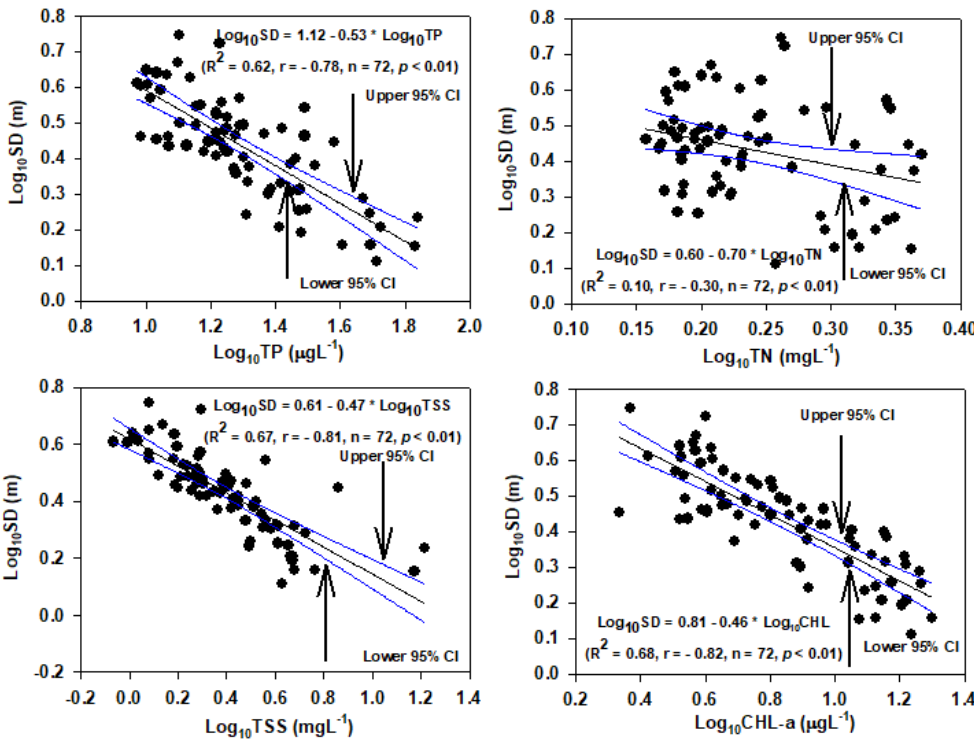
Figure 5. Relations among Secchi depth with nutrients (TP: total phosphorus, TN: total nitrogen), total suspended solids (TSS) and chlorophyll-a (CHL-a) in the Daecheong Reservoir. CI: confidence interval; average water quality data used from 2000–2018.